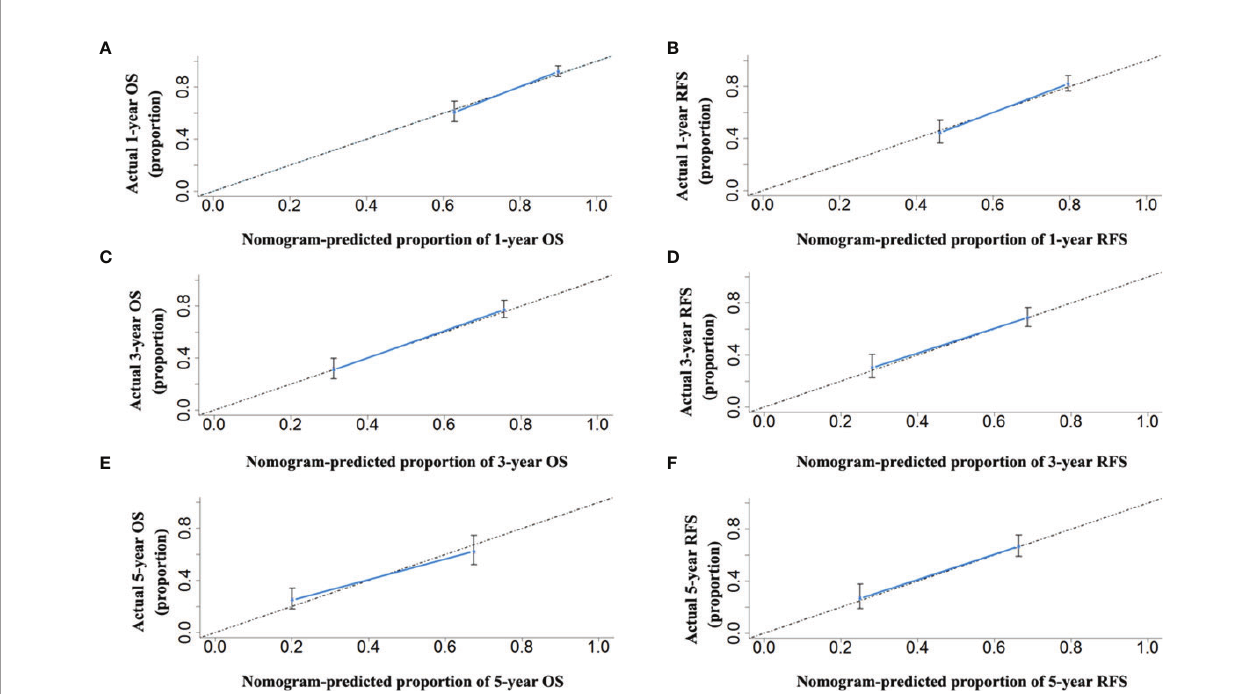
FIGURE 5 | The calibration curves for predicting the 1-, 3- and 5-year OS (A, C, E) and RFS (B, D, F) rates by nomogram prediction and actual observation in patients with HCC in the primary cohort.